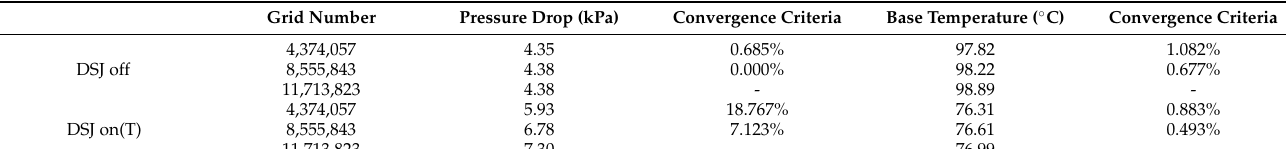
Figure 3. Boundary conditions of the calculation model.